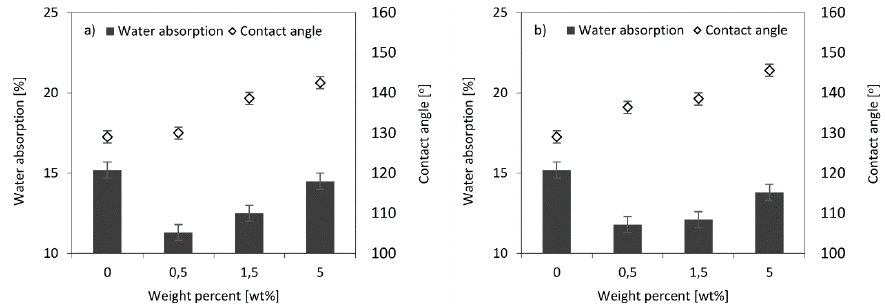
Figure 13. Effect of contact angle on water absorption of RPUFs modified with ( a ) APIB-POSS and ( b ) AEAPIB-POSS.